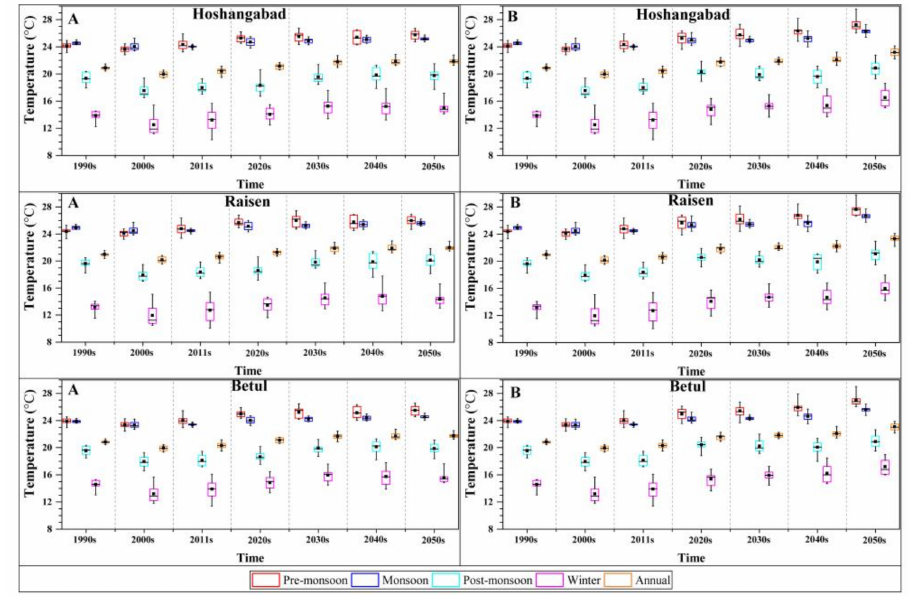
Figure 9. Minimum temperature of past and future (1990s to 2050s) using ACCESS1 of CMIP5 and scenarios are A = RCP4.5 and B =